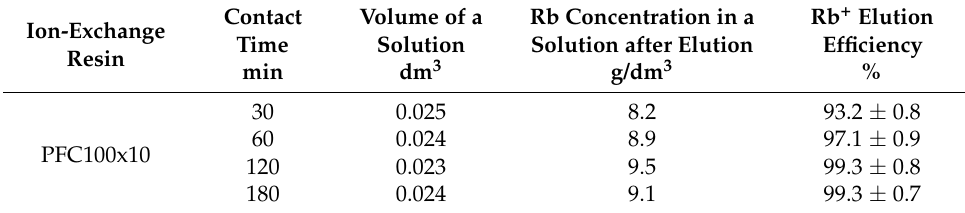
Table 5. Effect of the contact time on the rubidium ion elution